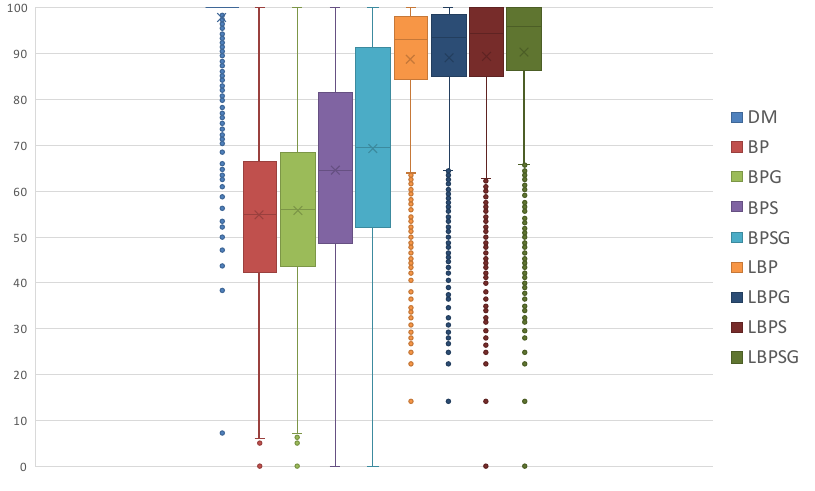
Figure 11. BP and LBP variants: LO jobs scheduled per task set in HC-MP scenario.